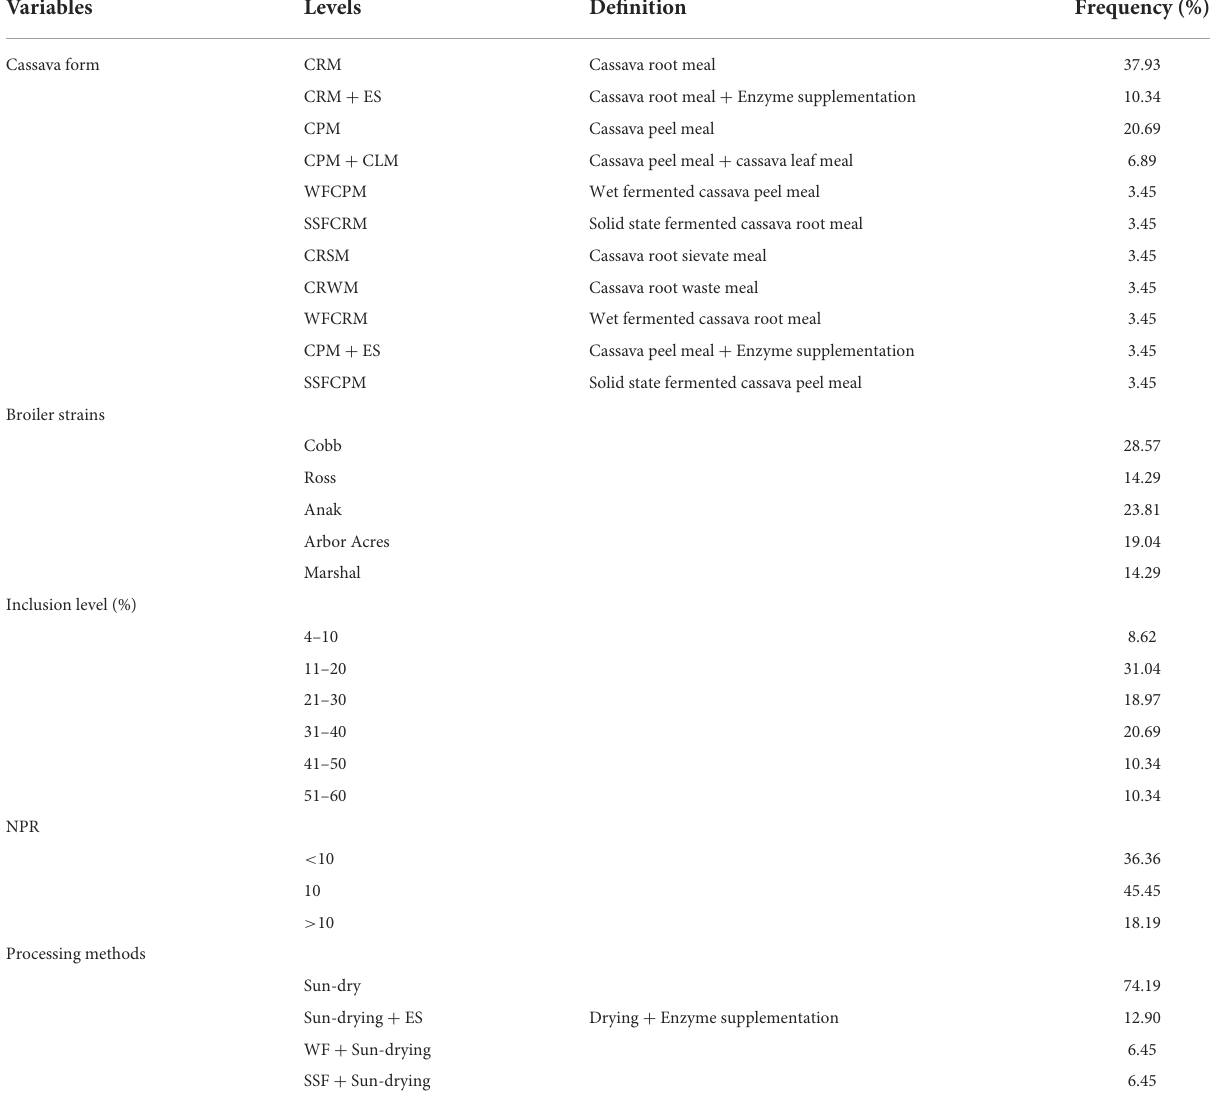
TABLE 1 Definition of moderator variables included in the meta-analysis and their distribution matrix.